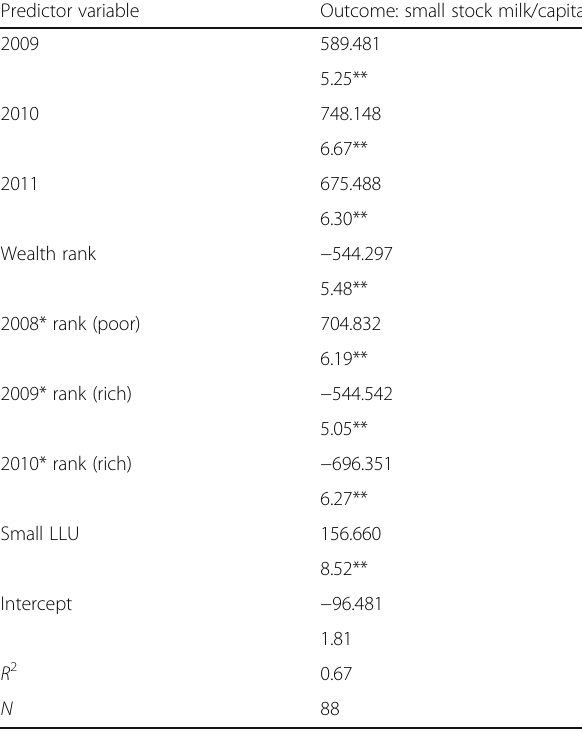
Significant predictor variables were year, wealth rank, and total lactating herd size. Values reported in the table are beta coefficient and t value . The asterisks indicate degree of significance LLU lactating livestock unit